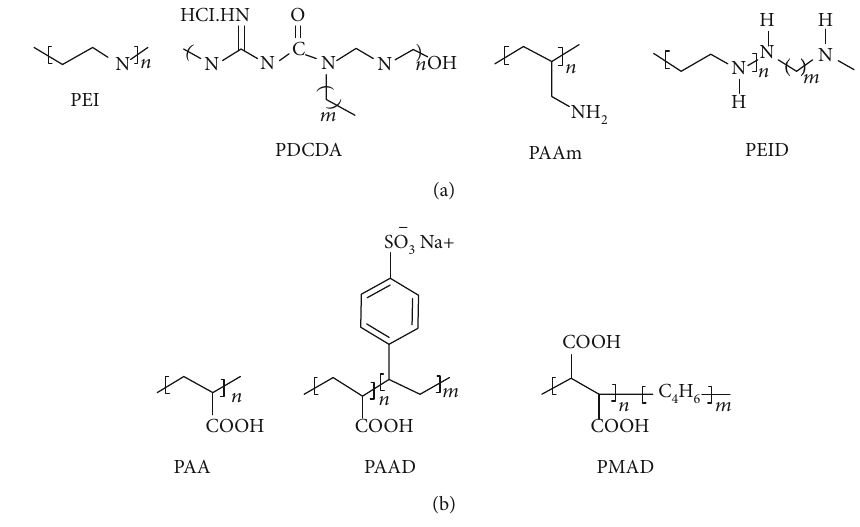
Figure 3: (a) Cationic and (b) anionic polymers as corrosion